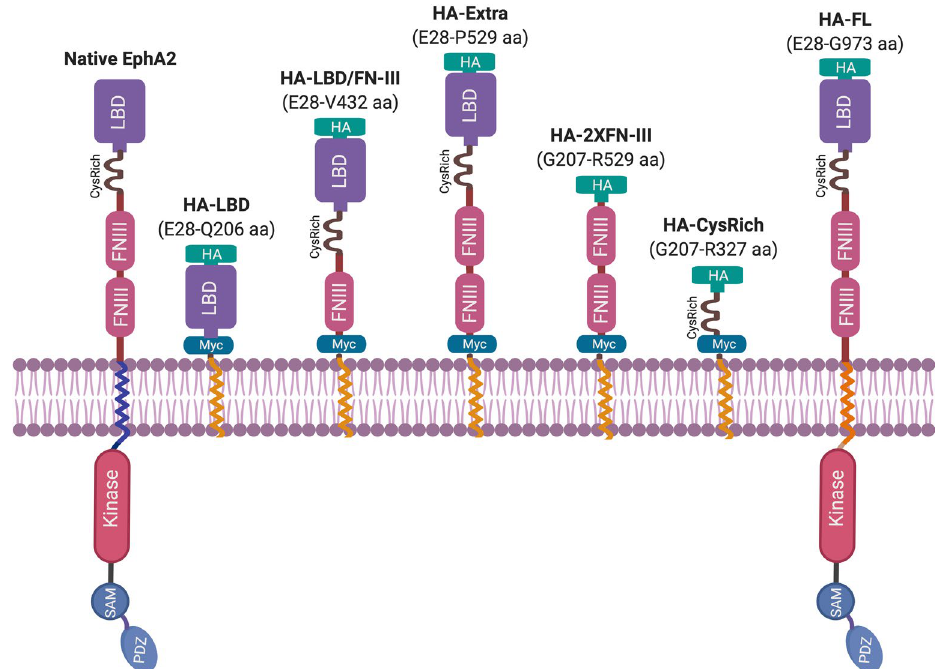
Figure 1. Schematic illustrations of recombinant EpA2 constructs. HA: HA-tag, myc myc-tag, LBD: ligand binding domain, CysRich: cysteine-rich domain, FNIII: fibronectin III repeat, Kinase: kinase domain, SAM: sterile α-motif domain, PDZ: PDZ-binding motif. The native TMD of EphA2 is depicted in blue; the PDGFR TMD is in orange. The figure was created with